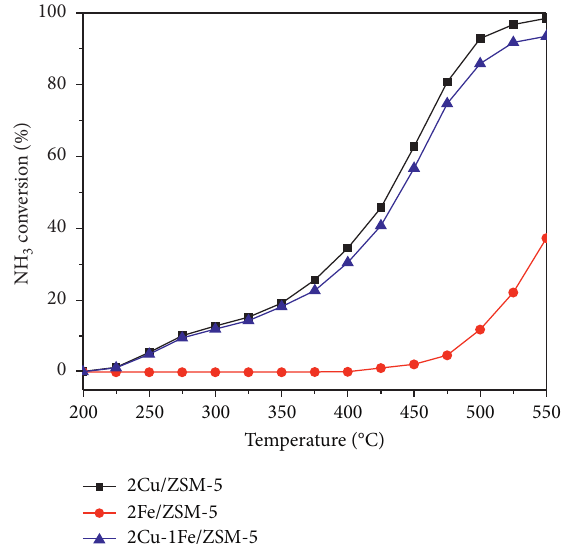
Figure 10: NH 3 conversion as a function of temperature during NH 3 oxidation experiment for the